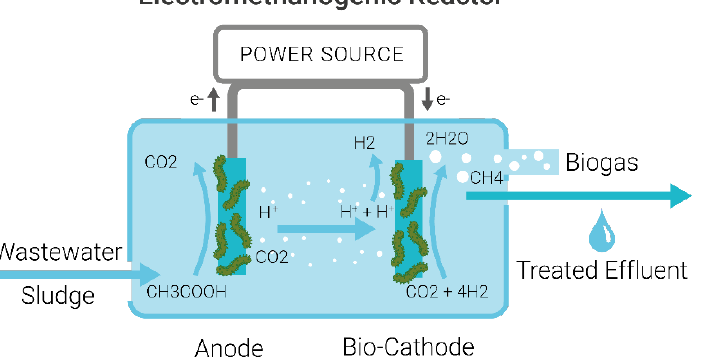
Figure 2. Schematic of a Microbial Electrolysis Cell-Anaerobic Digestion (MEC-AD) or Electro-Methanogenic Reactor for treating wastewater to produce CH 4 showing the wastewater influent and effluent and an anode and cathode connected to a power source.